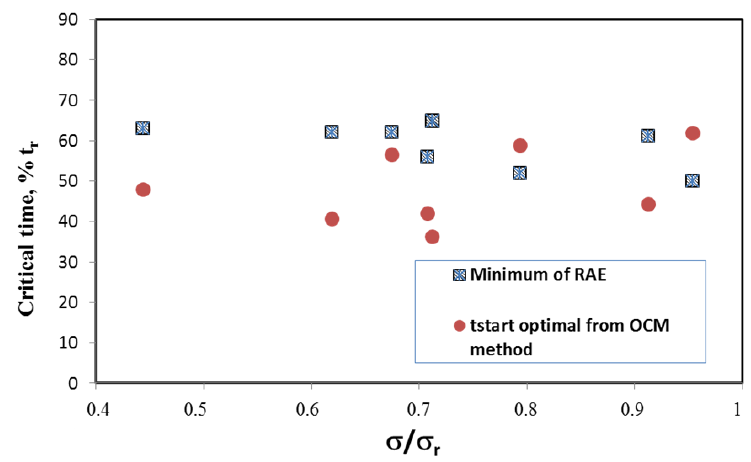
Figure 8. Evolution of the R AE coefficient during the static load hold on SiC f /[Si-B-C] composites.